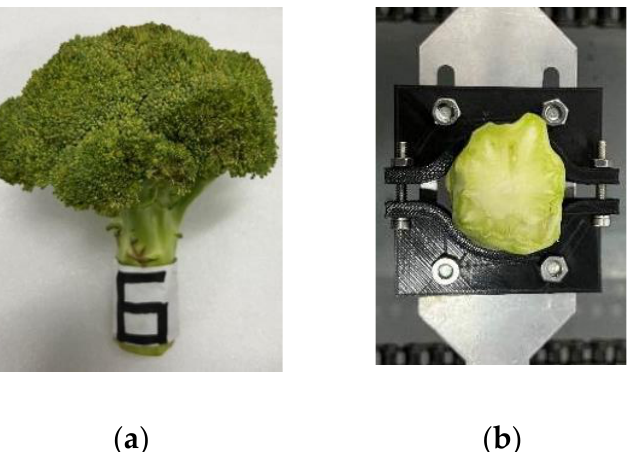
Figure 15. Successful picking factors: ( a ) Clamping damage was low, and plant height was greater than 12 cm; ( b ) The incision surface was flat and non-adhesive.